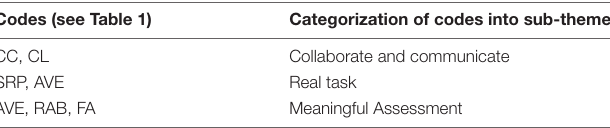
TABLE 4 | Categorizing codes from semi-structured interviews into three sub-themes. Codes (see Table 1) Categorization of codes into sub-theme Collaborate and communicate Real task AVE, RAB, FA Meaningful